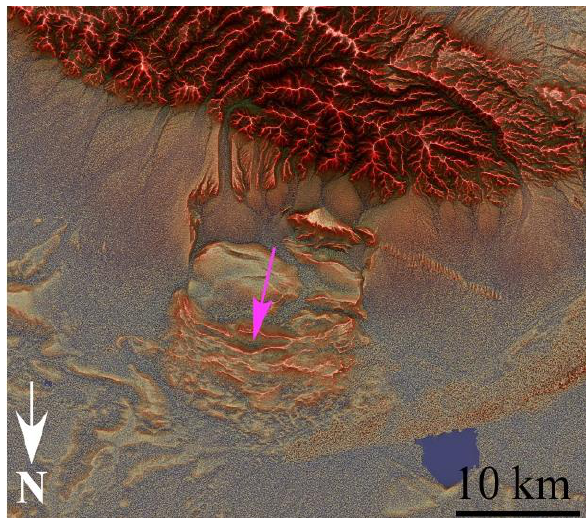
Figure 7. Baga Bogd landslide. Pink arrow indicates the moving direction of the